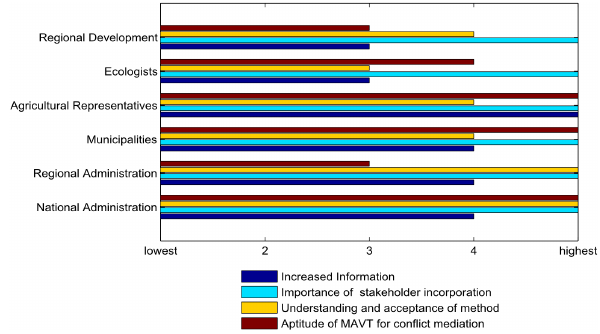
Figure 11. Average evaluation of the method based on stakeholders’